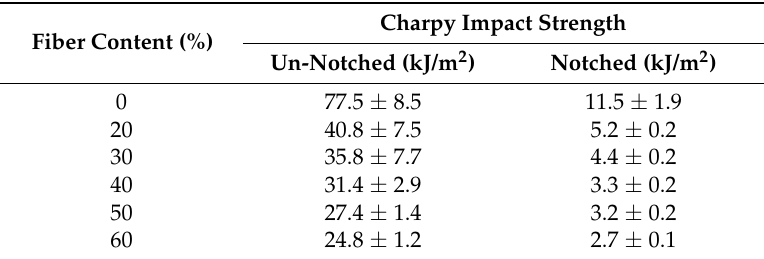
Table 1. Charpy impact strength for un-notched and notched PA11-SGW composites